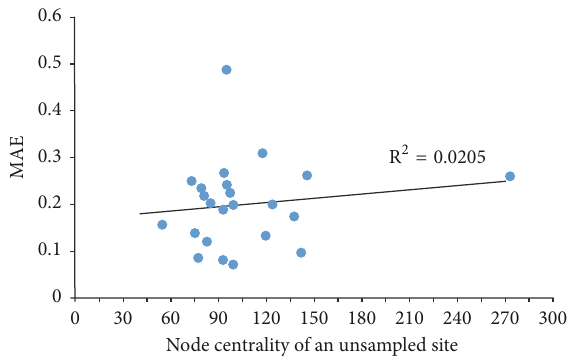
Figure 7: The spatial distribution of the interpolation errors (MAE and MBE) in the cross-validation.